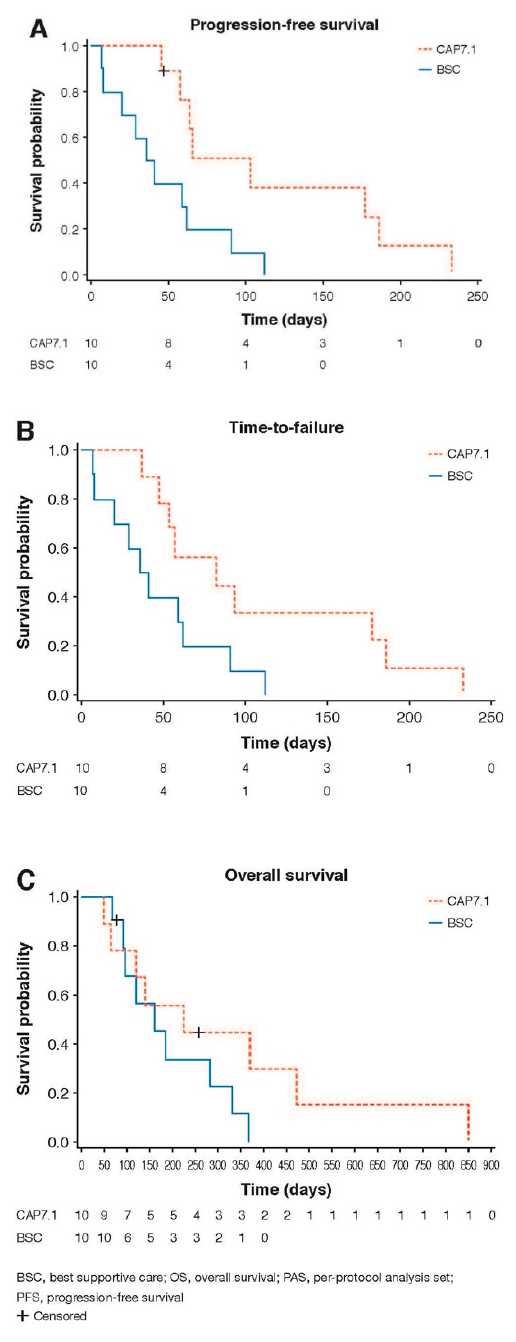
Figure 2. Secondary endpoint analysis results in the FAS for patients receiving early CAP7.1 vs. BSC patients who received CAP7.1 delayed after initial progression under BSC therapy: Kaplan–Meier estimates of ( A ) PFS for patients receiving CAP7.1 vs. BSC ( p = 0.009), ( B ) TTF for patients receiving CAP7.1 vs. BSC ( p = 0.010), and ( C ) OS for patients receiving CAP7.1 vs. BSC ( p = 0.148).